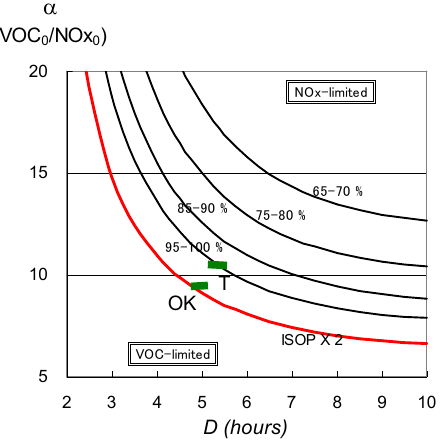
0 /NO x0 ) with nor- malized distance D (hours) under the meteorological conditions of various areal ozone percentile intervals (black lines). The red line shows the boundary for ISOP=5.24% of VOCs (instead of 2.62%; Table 1), under 95–100th percentile rank conditions. The two bars are regime boundaries estimated from the observed reversal of the OWE for TMA ( T ) and the Osaka-Kyoto area (OK) at the 98th per- centile rank of O 3max .